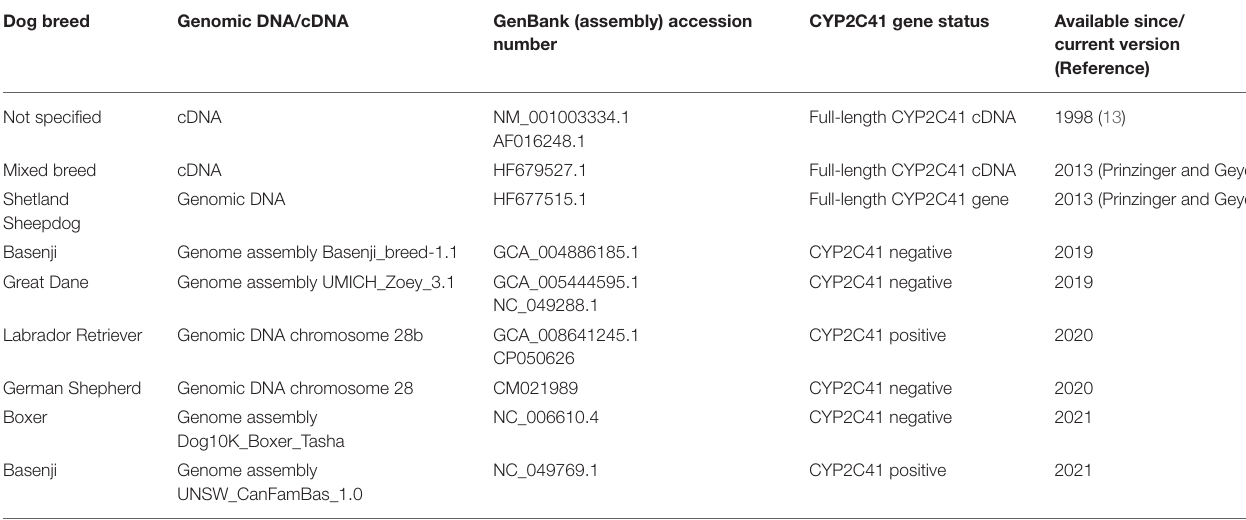
TABLE 2 | Available genomic CYP2C41 sequences of the dog. Dog breed